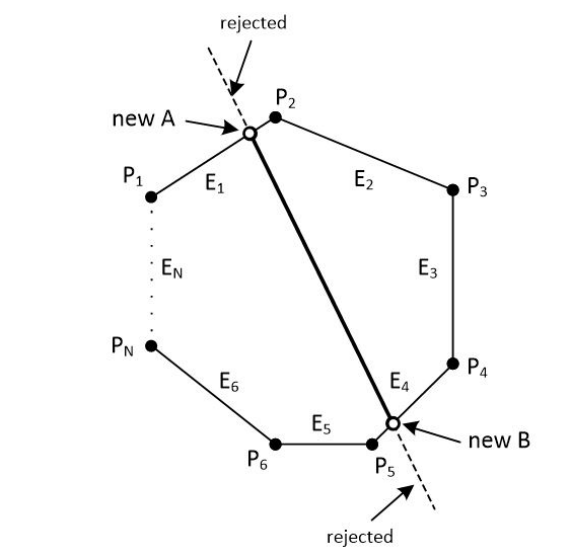
Figure 42. At the end, we draw a line segment from clipped point A to clipped point B